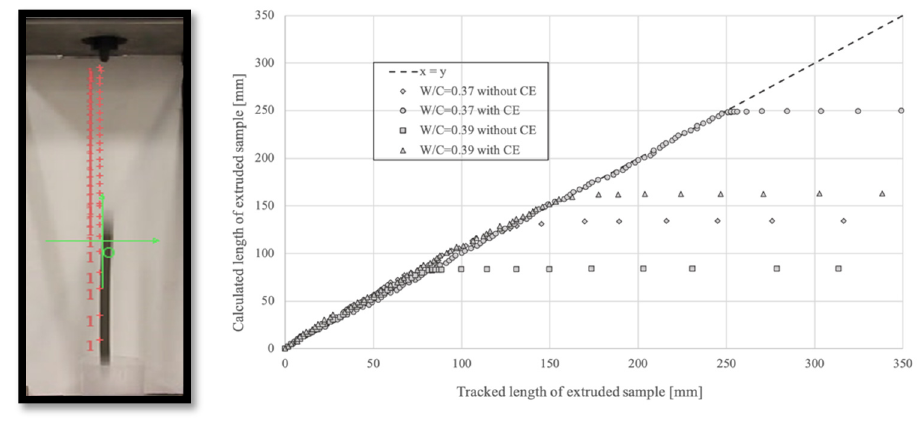
Figure 5. Comparison of the theoretical length of the unbroken specimen with the tracked position of the bottom end of the extrudates. The divergence between theory and measurement signifies the sample breakage. Table 2. Masses of the material leading to extrudates fracture, obtained by the weighting of the fallen samples, and by video tracking from which the corresponding tensile strength of the material is computed. Tests are carried out at a piston velocity of 25 mm/min (omitting viscous effects). ρ m weigthed m computed Deviation σ tens,GD, from video from video tracking tracking [kg/m 3 ] [g] [g] [g] [kPa] Without CE W/C = 0.37